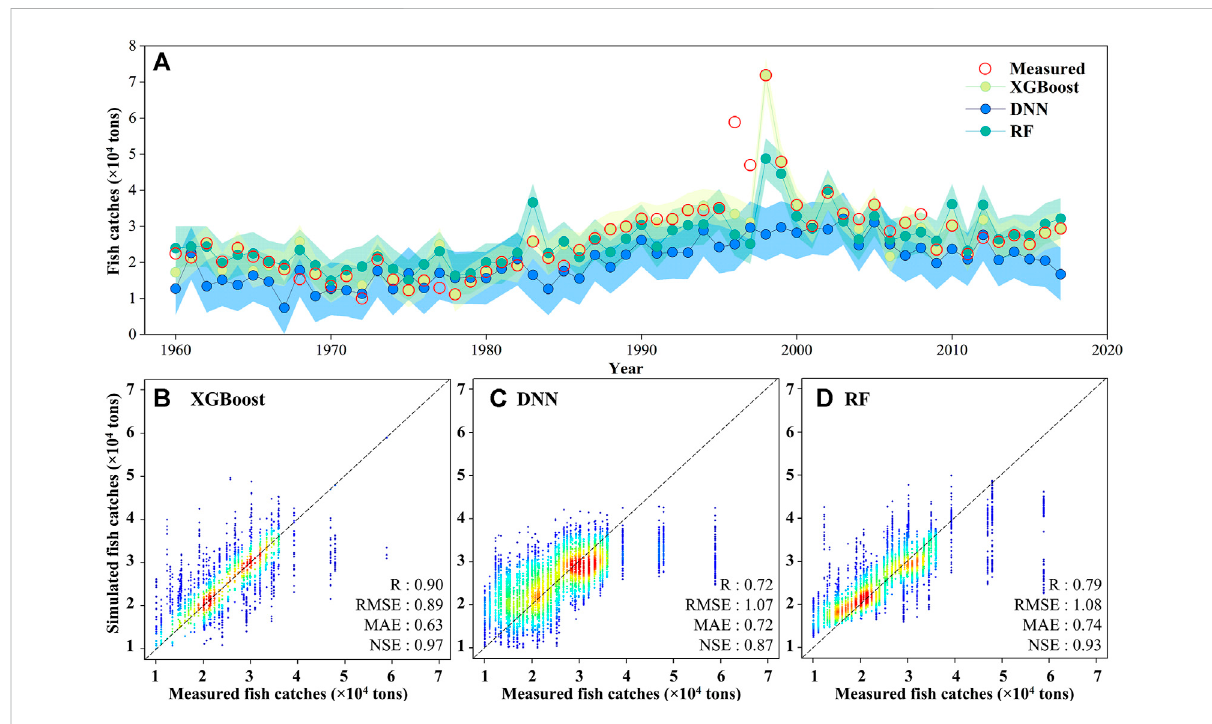
FIGURE 8 Predicted fi sh catches of Poyang Lake based on XGBoost, DNN, and RF models (A) and performance evaluation of the XGBoost (B) , DNN (C) , and RF (D)